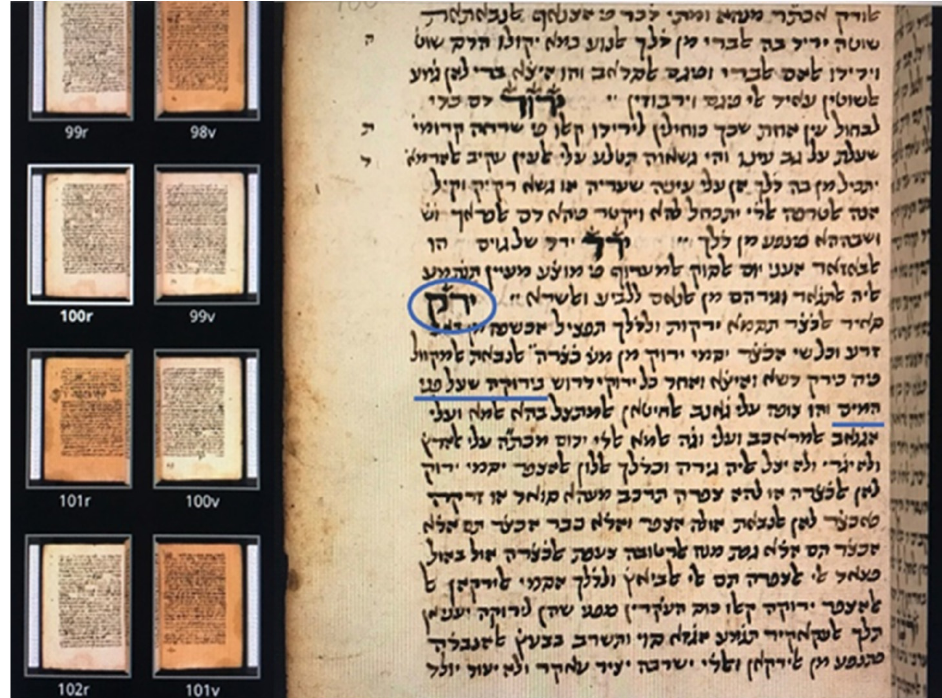
Figure 3. Part of a manuscript page from Tanchum of Jerusalem’s dictionary of terms in Maimonides’ Code of Law. Bodleian Library MS. Huntington 621, University of Oxford. [40] Manuscript date: 1393 CE. Language: Judaeo-Arabic and Hebrew. Folio page100r includes the entry for “ Yerek ” (circled in blue; literally “Greenery”). In the description of this term, Tanchum refers in Hebrew to “yaroka on the surface of the water” (underlined in blue), and, in Judaeo-Arabic, continues by describing this water as: “which remains on the ground without moving and is not flowing”.